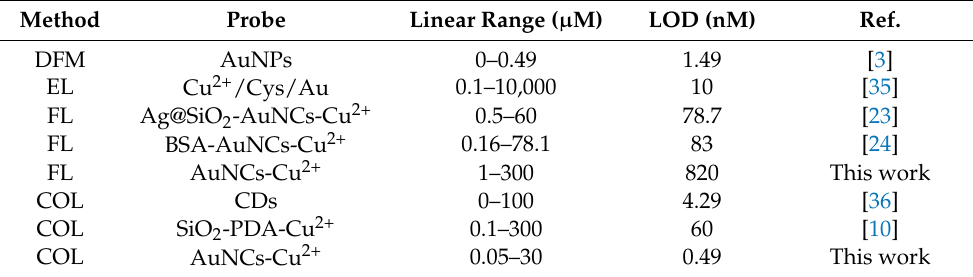
Table 1. Performance comparison of the detection methods for detection of PPi.